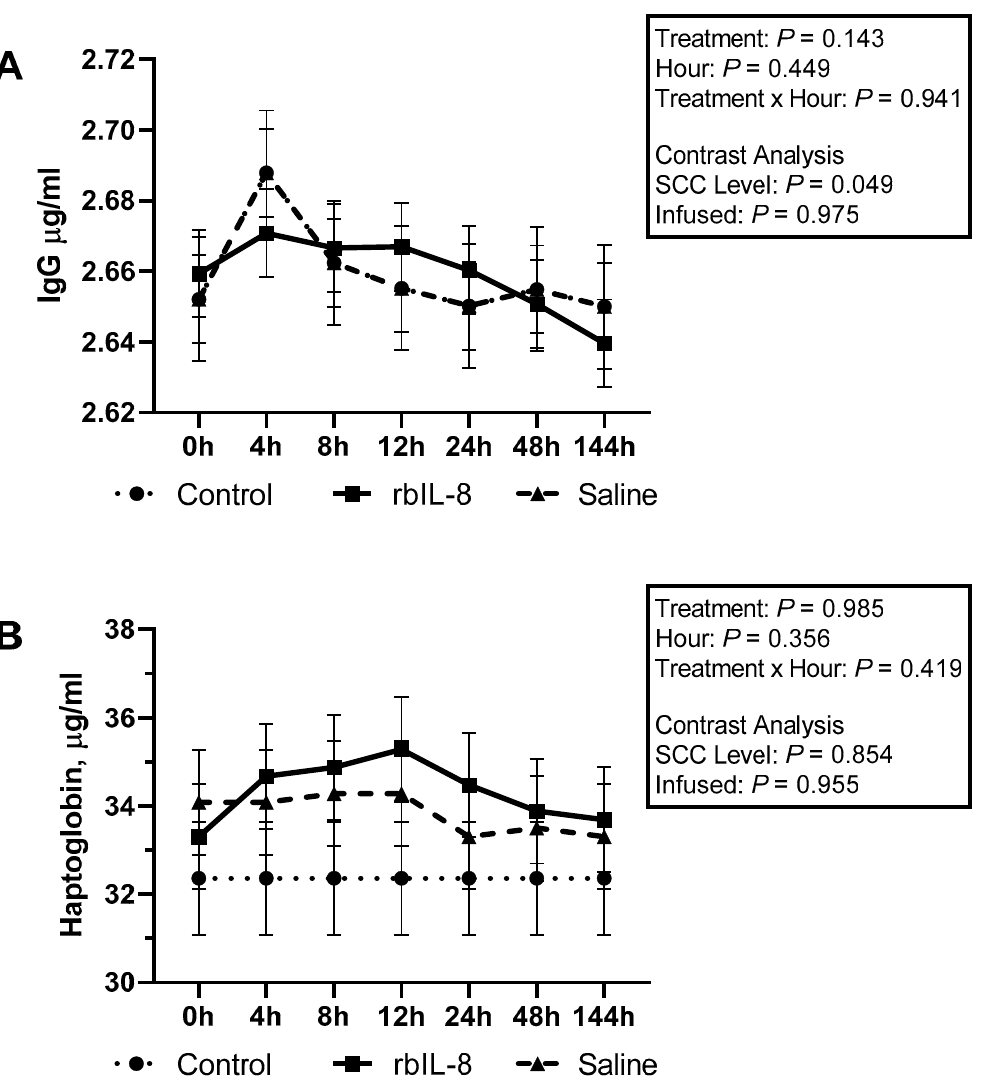
Figure 8. Concentrations of IgG ( A ) and haptoglobin ( B ) in milk relative to treatment for each group. Treatment effect is a multiple comparison among the groups. The SCC level was measured using a contrast comparing the chronic groups (rbIL-8 and saline) to the control, whereas the infused compares the rbIL-8 with the saline. Multiple comparisons were adjusted for Tukey–Kramer; p = ≤ 0.05 means a statistical significance, and 0.05 < p ≤ 0.10 means a statistical tendency.